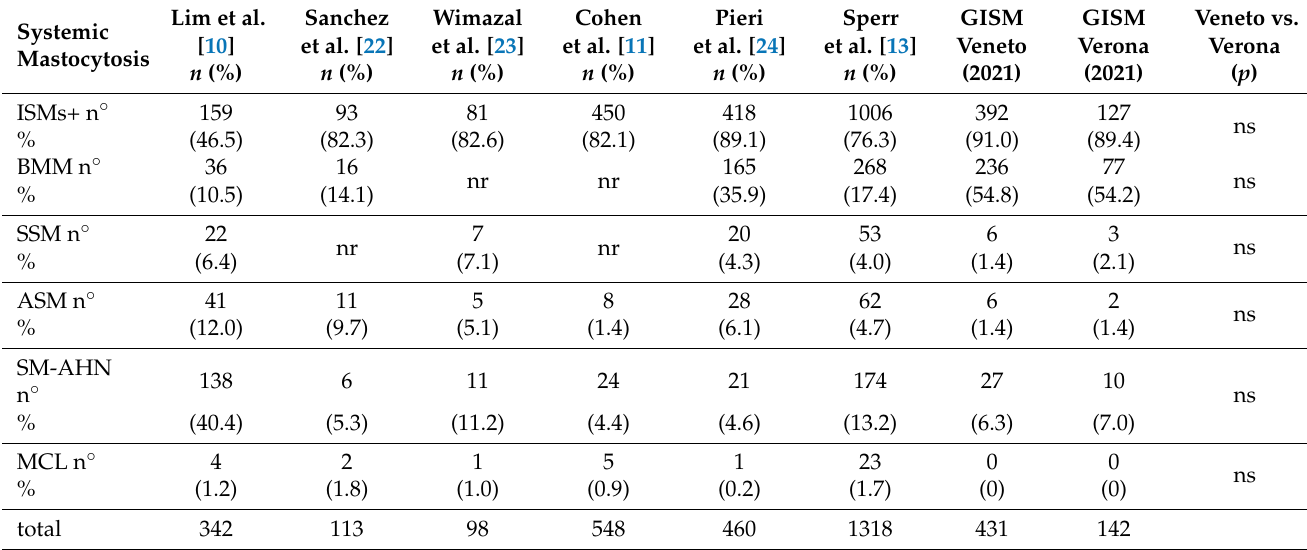
Table 1. Comparison between the frequencies of the variants of systemic mastocytosis in the present study and those reported in the main series of literature.